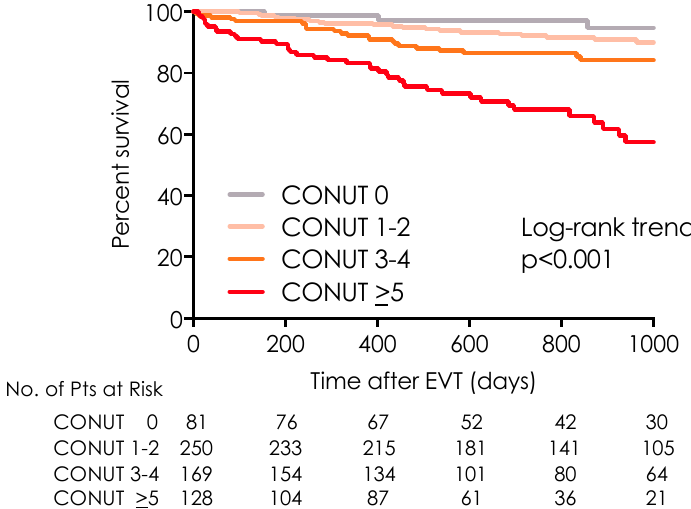
Figure 2. All-cause mortality after endovascular therapy. Kaplan–Meier curves of all-cause mortality among the four subgroups categorized according to the Controlling Nutritional Status score on admission. CONUT = Controlling Nutritional Status score; EVT, endovascular therapy.